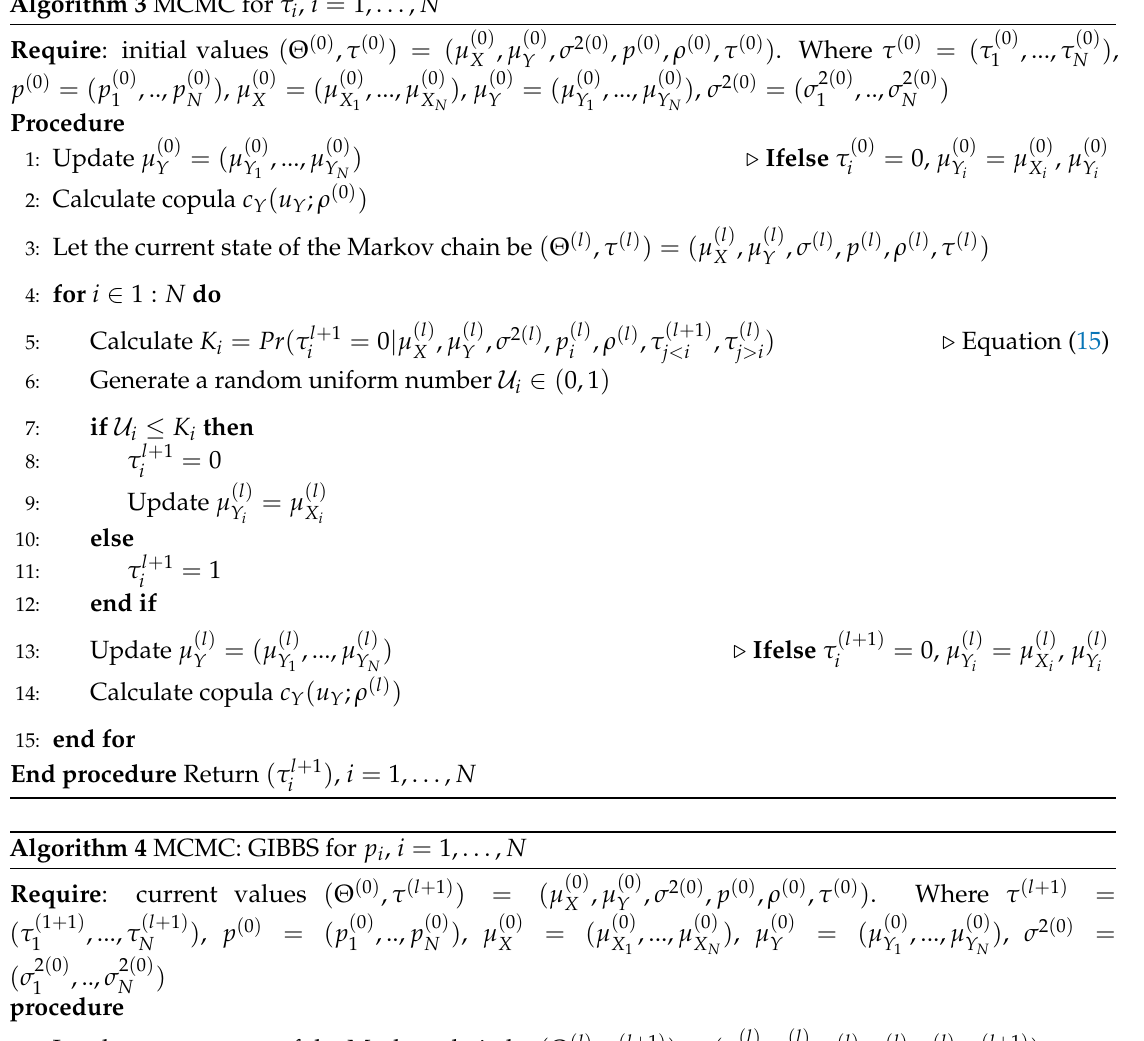
Algorithm 3 MCMC for τ i , i = 1, . . . , N